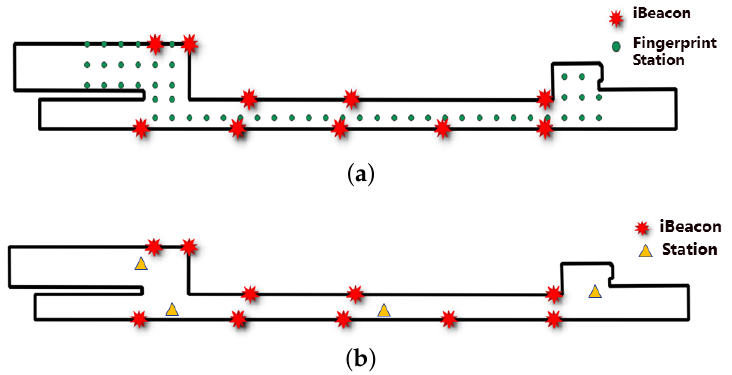
Figure 9. Reference points for fingerprinting: ( a ) points for fingerprinting in offline phase; and ( b ) four points for the adjustment of ranging